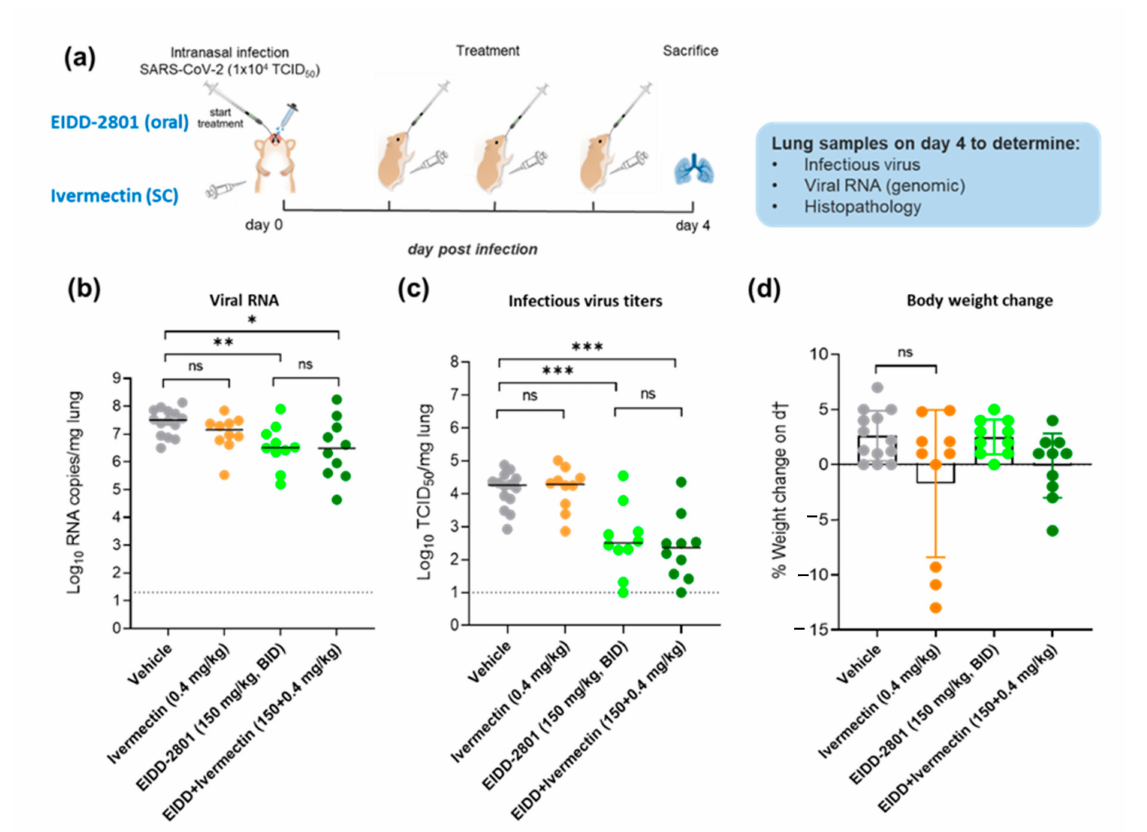
Figure 1. Antiviral efficacy of ivermectin as a single or combination therapy against SARS-CoV-2 beta (B.1.351) variant in a hamster infection model. ( a ) Setup of the study. ( b ) Viral RNA levels in the lungs of control (vehicle-treated), ivermectin-treated (0.4 mg/kg, QD), EIDD-2801-treated (150 mg/kg, BID), and combination-treated (EIDD-2801+ivermectin at 150 mg/kg BID+0.4 mg/kg QD) SARS-CoV-2 (B.1.351)-infected hamsters at day 4 post-infection (pi) are expressed as log10 SARS-CoV-2 RNA copies per milligram lung tissue. Individual data and median values are presented. ( c ) Infectious viral loads in the lungs of control (vehicle-treated), ivermectin-treated, EIDD-2801- treated and combination-treated (EIDD-2801+ivermectin) SARS-CoV-2-infected hamsters at day 4 pi are expressed as log 10 TCID 50 per milligram lung tissue. Individual data and median values are presented. ( d ) Weight change at day 4 pi in percentage, normalized to the body weight at the time of infection. Bars represent means ± SD. Data were analyzed with the Mann − Whitney U test. * p < 0.05, ** p < 0.01, *** p < 0.001, ns = non-significant. EIDD = EIDD-2801. All data (panels b , c , d ) are from